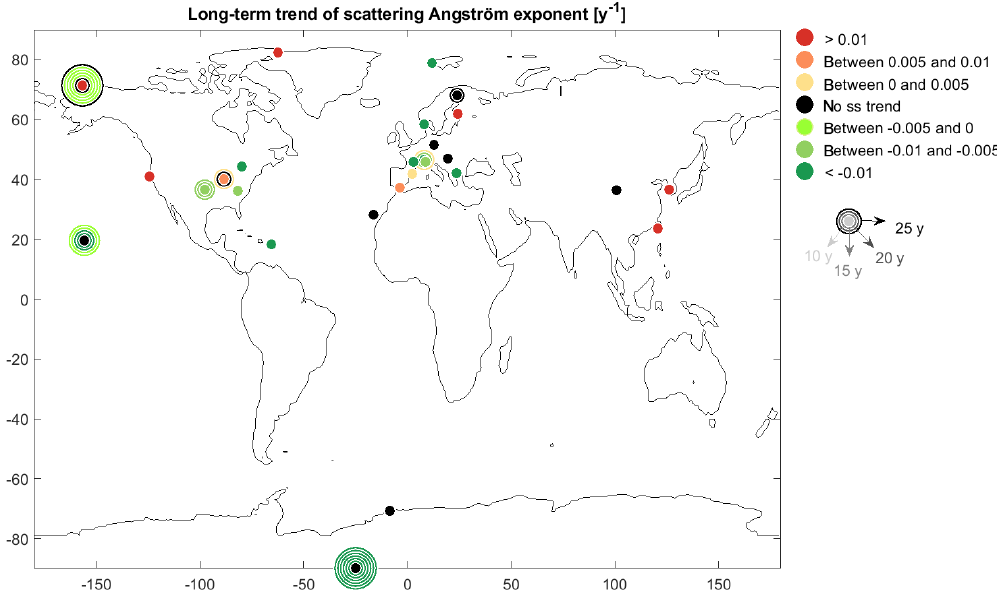
Figure 10. MK trend results for the scattering Ångström exponent. Other details same as Fig.